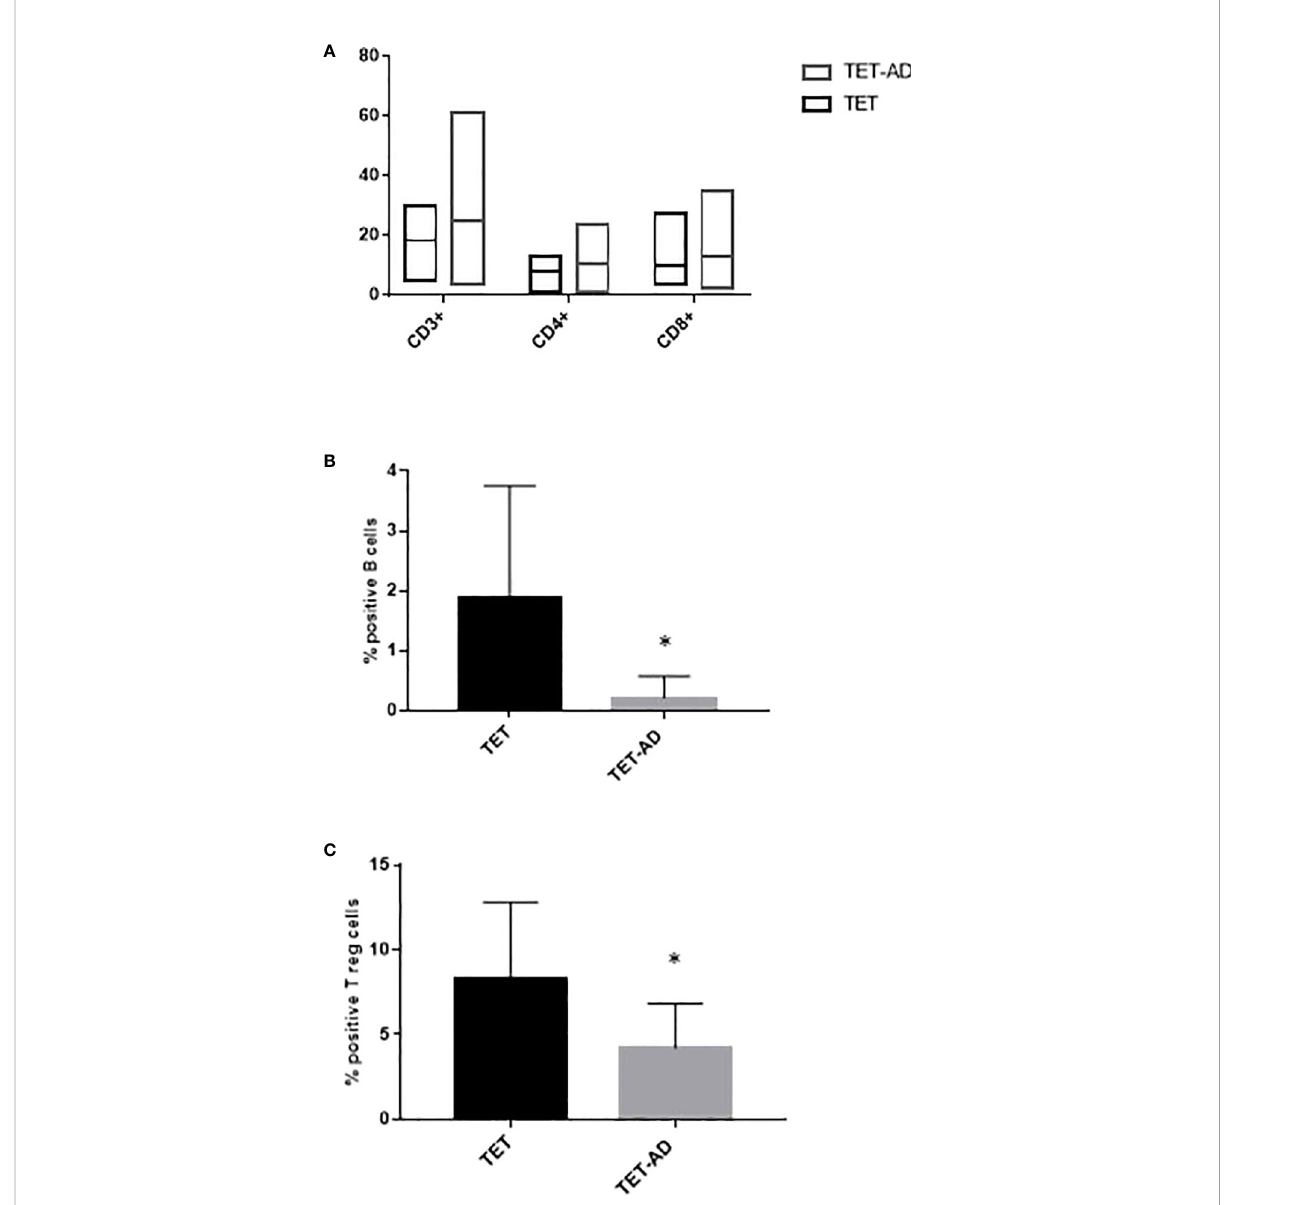
FIGURE 2 Flow cytometry pro fi le of immune cell subsets. Immunophenotype of T cells, CD3+, CD4+, CD8+ (A) , B cells (B) and Treg cells (C) is reported for TET and TET-AD patients. Results are represented as mean values ± SD. The statistical analysis was performed by Mann-Whitney test *p <